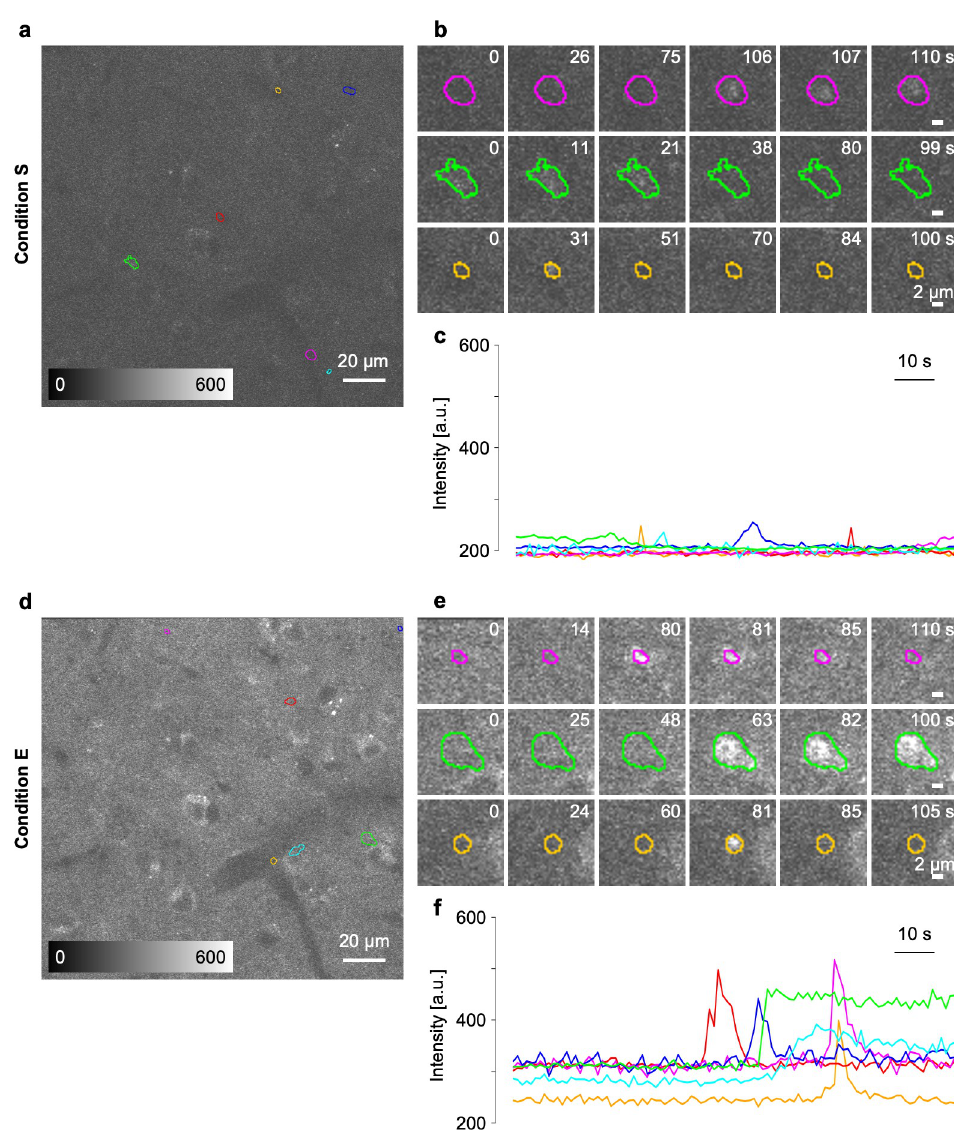
Fig 6. Two-photon imaging of spontaneous Ca 2+ activities of cortical layer V astrocytes under condition E. (a, d) Fluorescence images of G7NG817-line mouse cortical layer V obtained in the same field of view under (a) condition S and (d) condition E. The colored region of interests (ROIs) show the activated area detected computationally. (b, e) Examples of dynamics of fluorescence intensity derived from the spontaneous activity in the automatically set ROIs. (c, f) The time course of fluorescence intensity in the ROIs. The scale bars in (a, c) and (b, d) represent 20 and 2 μ m, respectively. (Fig 7B and 7D). Surprisingly, we achieved the laser ablation of the single basal dendrites of layer V pyramidal neurons (Fig 7B). To investigate the effect of the focal laser ablation on both the targeted and non-targeted neurons, the same 3D area was observed the following day. The dissected apical dendrites showed degeneration over a length of 100 μ m only along the distal direction. Nevertheless, the upper apical tufts maintained their original positions (n = 4 from two mice). In the closely located visible non-targeted neurons, their processes did not show any morphological distortions after the focal laser ablation (Fig 7D).